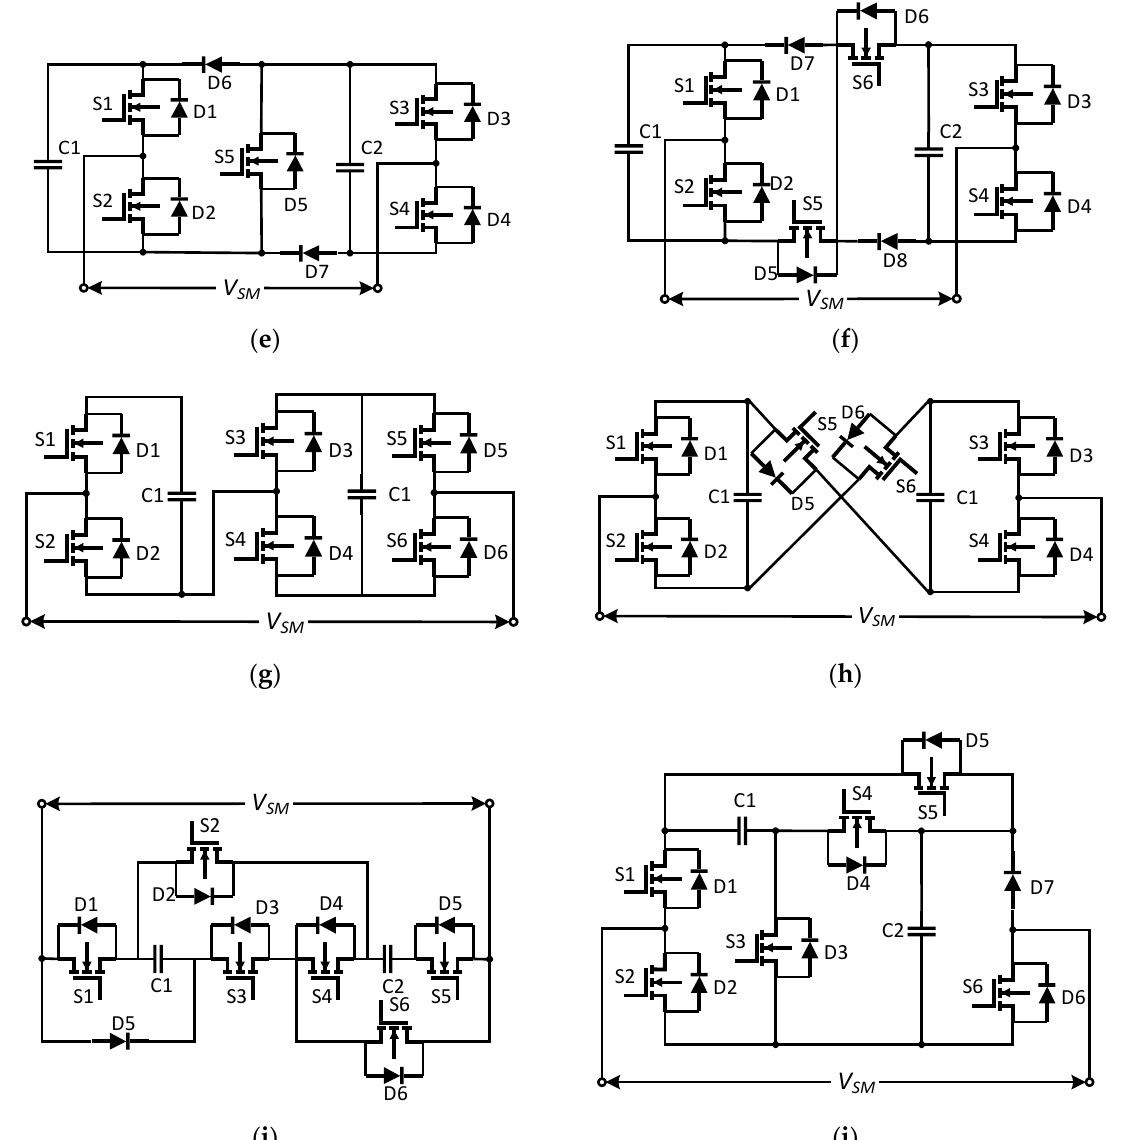
Figure 3. Multilevel submodule topologies: ( a ) neutral point clamped submodule (NPCSM); ( b ) flying capacitor submodule (FCSM); ( c ) cascaded half-bridge submodule (CHBSM); ( d ) stacked switched capacitor submodule (SSCSM); ( e ) clamp-double submodule (CDSM) type- Ⅰ ; ( f ) CDSM type- Ⅱ ; ( g ) hybrid submodules (HSM); ( h ) cross-connected submodule (CCSM); ( i ) switched capacitor submodule (SCSM); ( j ) composite three-level submodule (CSM).